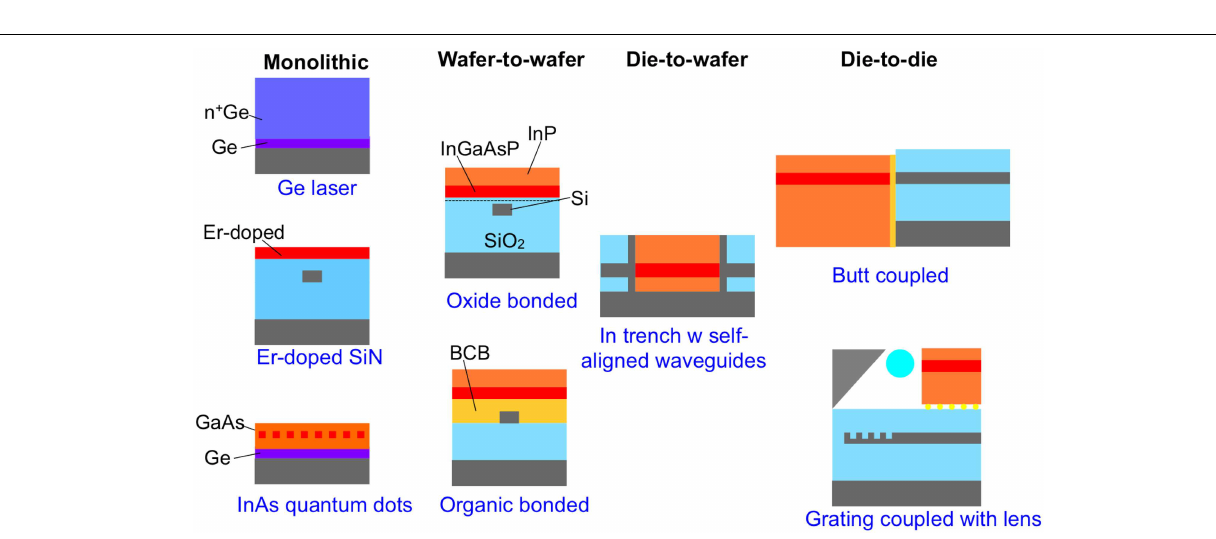
FIGURE 11 | Configurations for integrating optical gain into silicon photonics. Fabrication insertion point becoming later in the process as one moves from left to